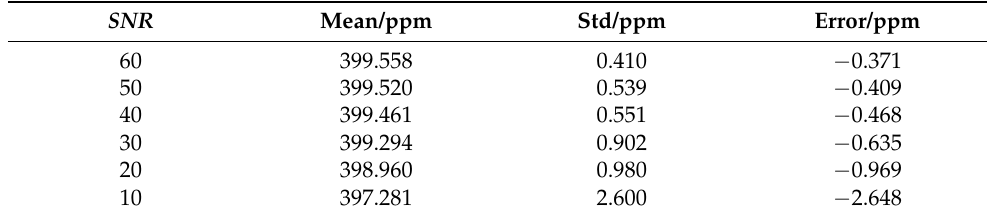
Figure 6. Retrieval results using SNR of ( a ) 60; ( b ) 50; ( c ) 40; ( d ) 30; ( e ) 20; ( f ) 10, respectively. The actual retrieval results (blue dot), averages of retrieval results (green dotted-line) and true values (red line) are shown. Table 2. Retrieval results of different SNR